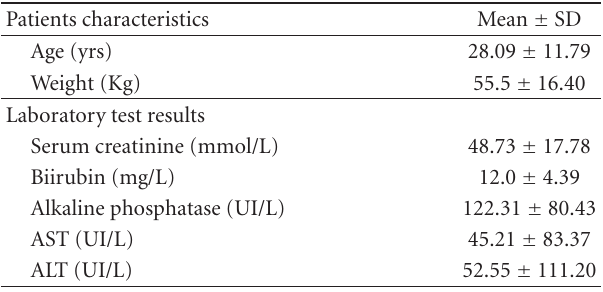
Table 1: Characteristics and laboratory test results of allogenic hematopoietic stem cell transplantation ( N = 60).